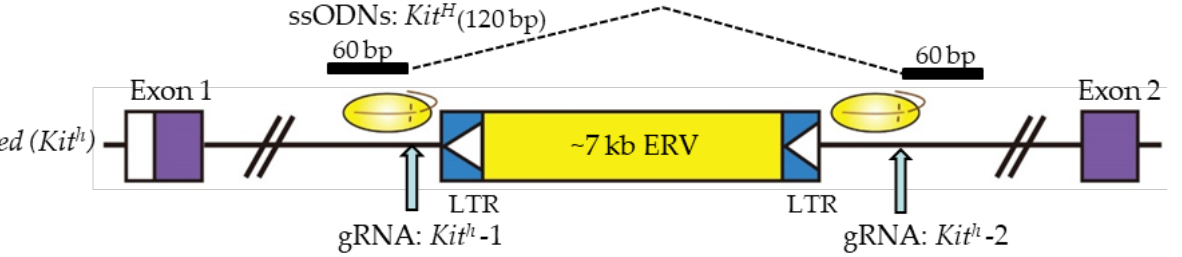
Figure 2. Schematic illustration of single-stranded oligodeoxynucleotide (ssODN)-based deletion of a large fragment spanning a 7,098-bp endogenous retrovirus (ERV) element within the first intron of the Kit gene. This figure was drawn in-house, based on the data shown in the paper of Yoshimi et al. [46].